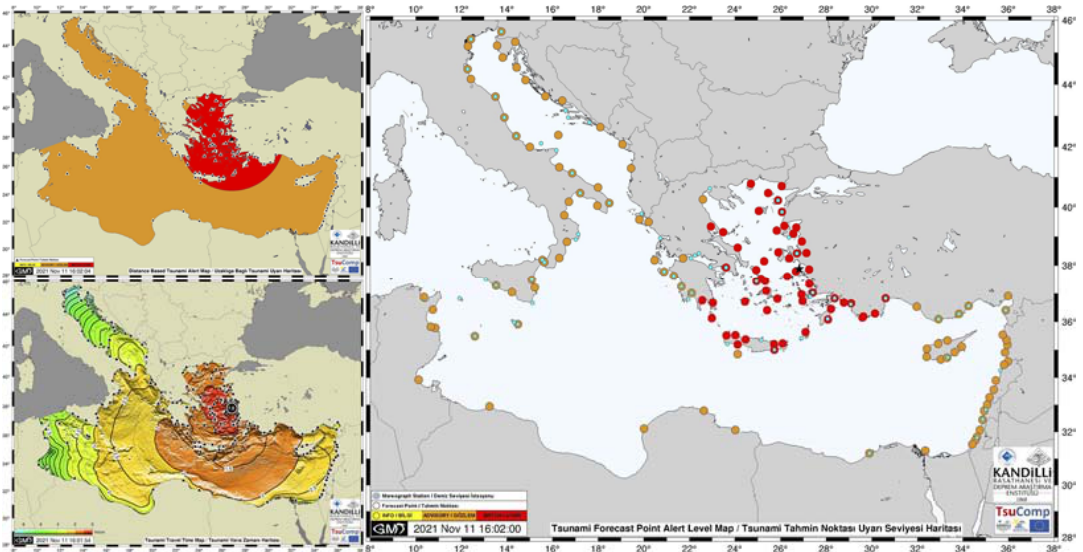
Figure 6. Distance–based tsunami alert map ( top left ), tsunami travel time map ( bottom left ) and tsunami forecast point alert level map ( right ) disseminated to KOERI–TSP subscribers for the 30 October 2020 Samos earthquake based on the Mw 7.0 assessment used in the initial warning message.